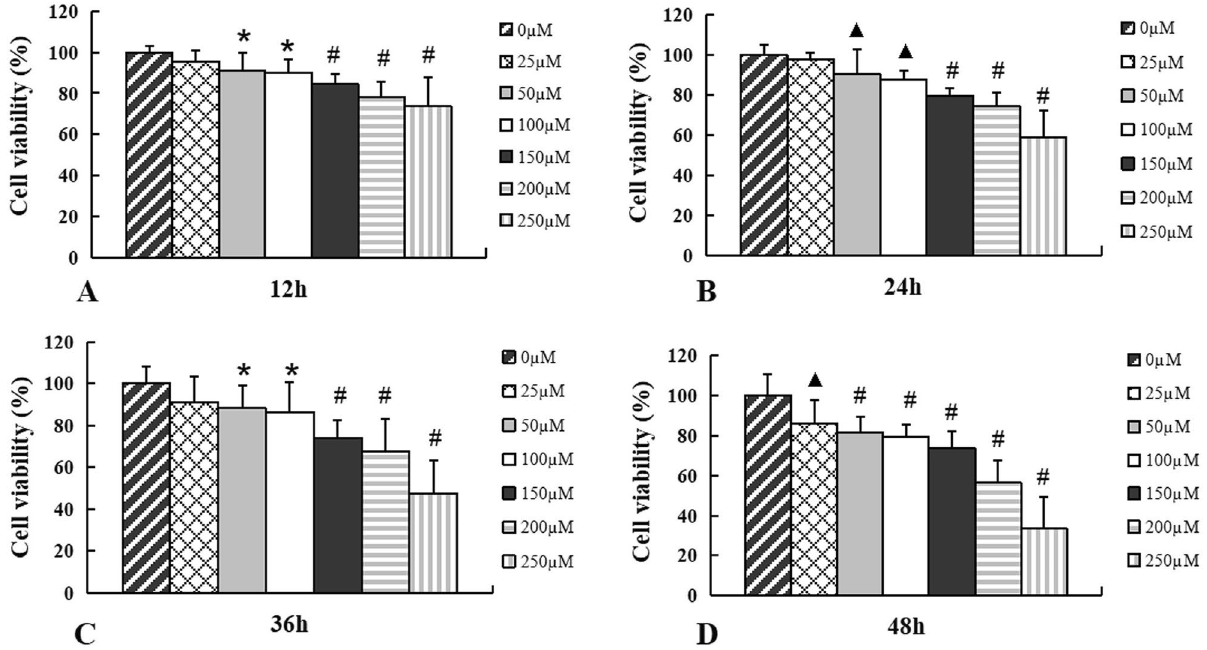
Figure 1. H 2 O 2 treatment decreases cell viability of MECs. Cell viability of MECs was reduced after exposure to H 2 O 2 at different concentration for 12 h ( A ), 24 h ( B ), 36 h ( C ), 48 h ( D ) respectively compared with controls. Data are represented as mean ± SD (n = 6),* p < 0.05, ▲ p < 0.01; # p < 0.001, control versus H 2 O 2 treatment groups. MECs, meningothelial cells.